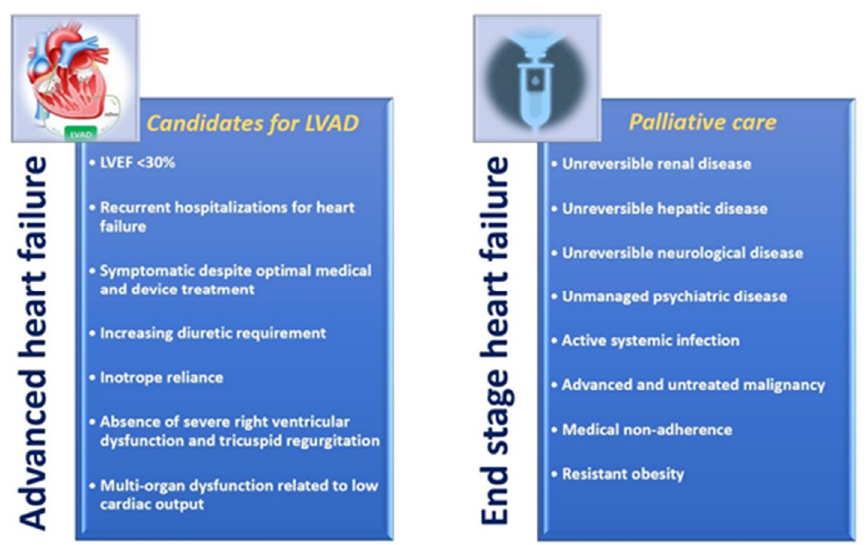
Figure 1. Schematic differences between advanced and end-stage heart failure. LVEF: left-ventricular ejection fraction.